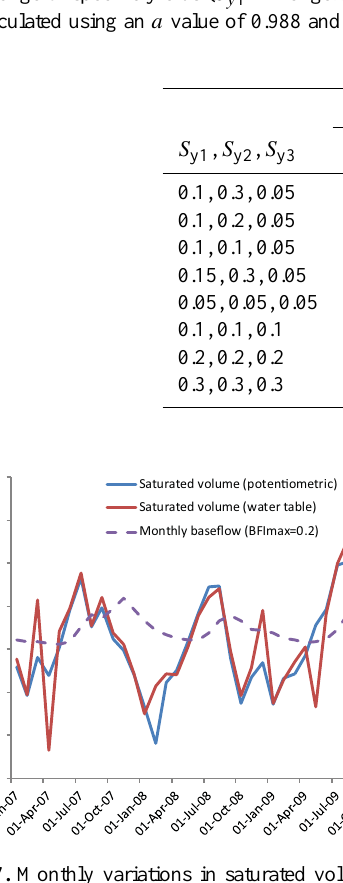
Figure 7. Monthly variations in saturated volumes for the catch- ment area with elevation < 100m for both the potentiometric and water table data sets and for monthly baseflow derived from Eck- hardt analysis (using a BFI max value of